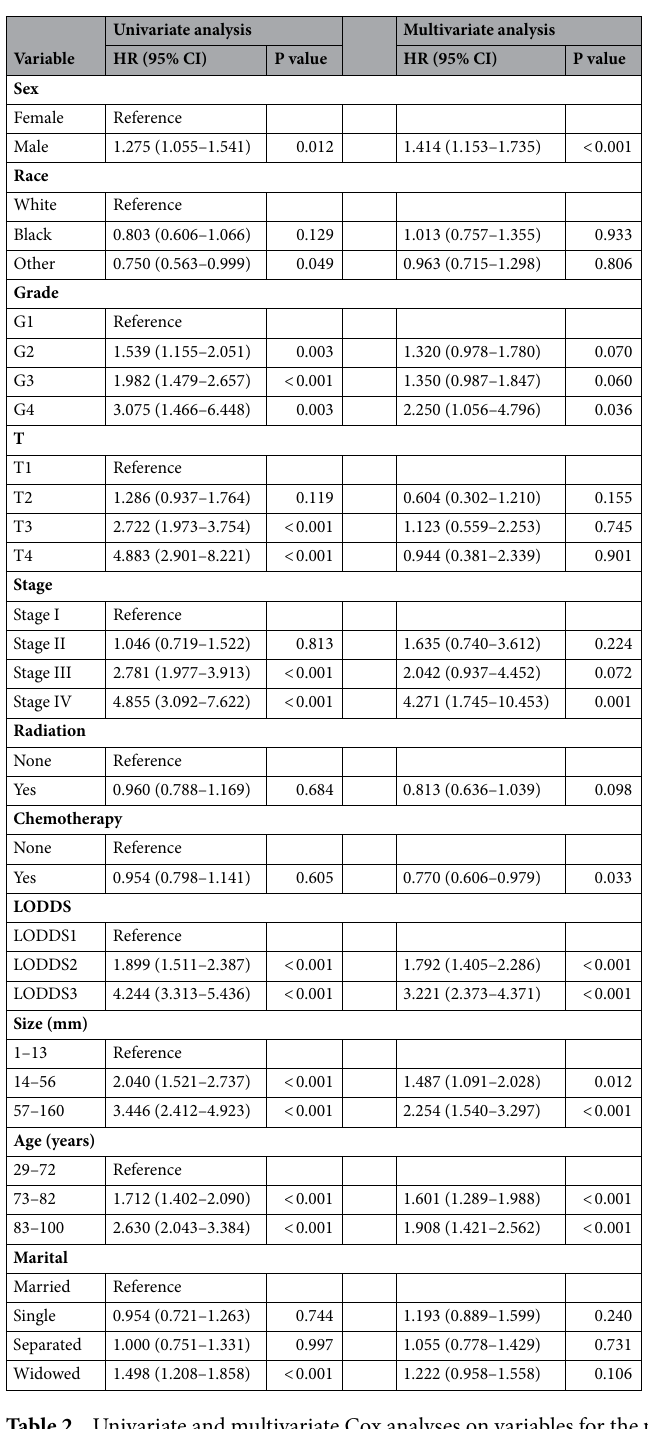
3 (265 ≤ total points < 296), and nomo 4 (total points ≥ 296). As shown in Fig. 4, the differences between the